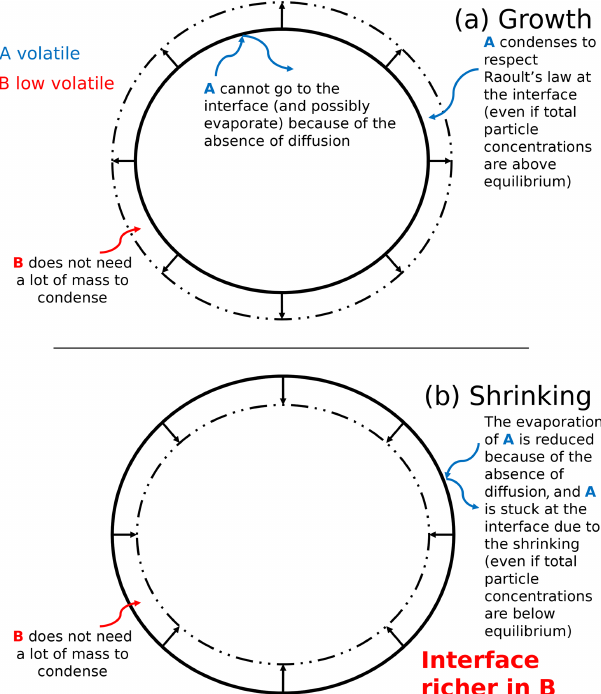
Figure 5. Schematic representation of SOA formation for a grow- ing (a) and shrinking (b) highly viscous aerosol. The blue curved arrows describe the behavior of an organic compound A (blue), and the red curved arrows describe the behavior of a low-volatility or- ganic compound B